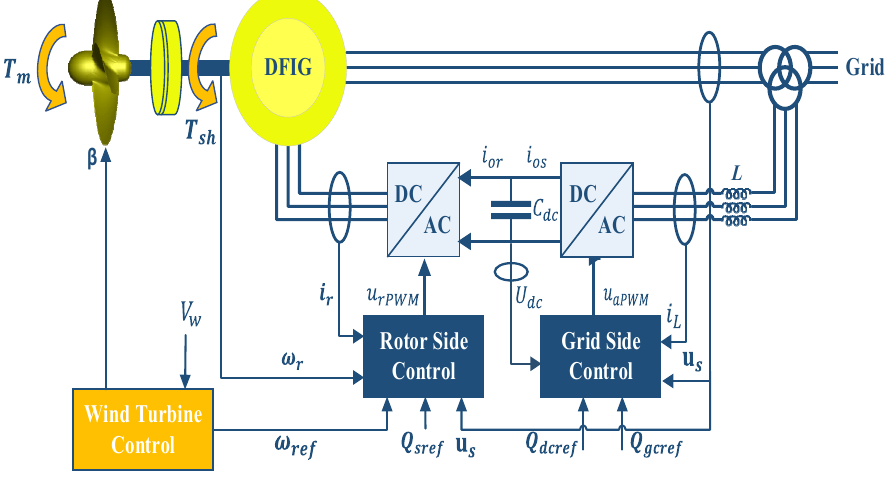
Figure 1. Schematic diagram of the DFIG WT structure.